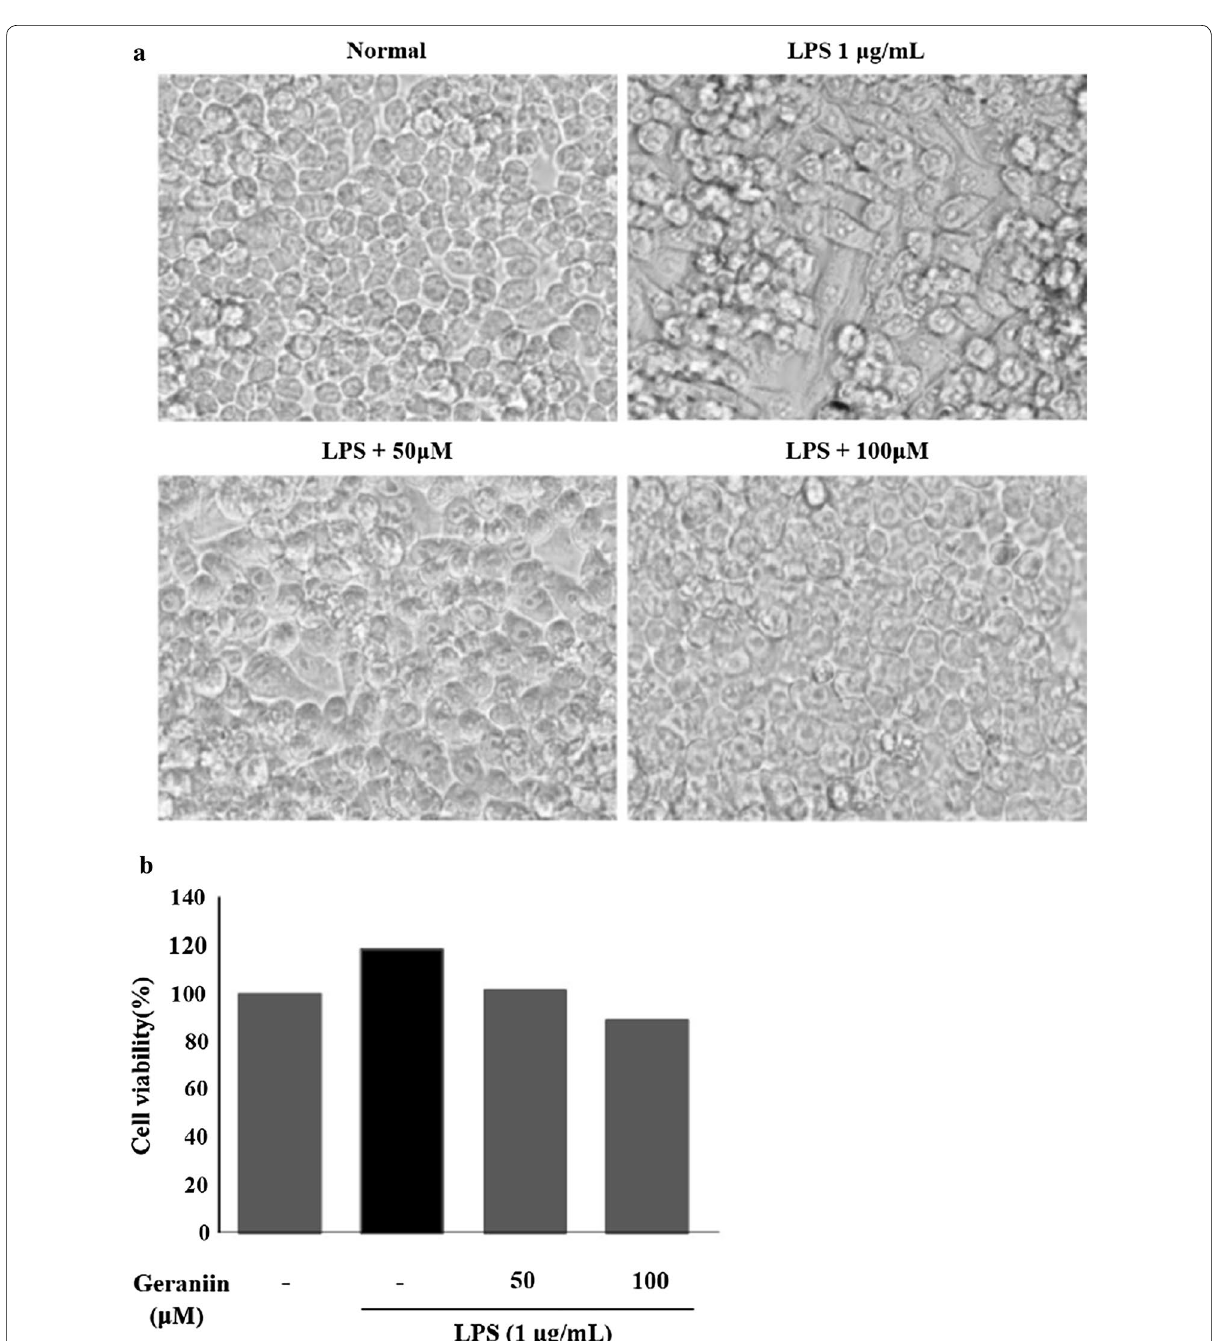
Fig. 1 Morphological transformation ( a ) and cell viability ( b ) on LPS-induced Raw 264.7 cells. Cells treated with the geraniin (0, 50 and 100 µM) for 24 h. The cell viability was determined using a cytotoxicity assay kit and showed not significant cytotoxicity. The morphology was visualized by a light microscope at 200 ×